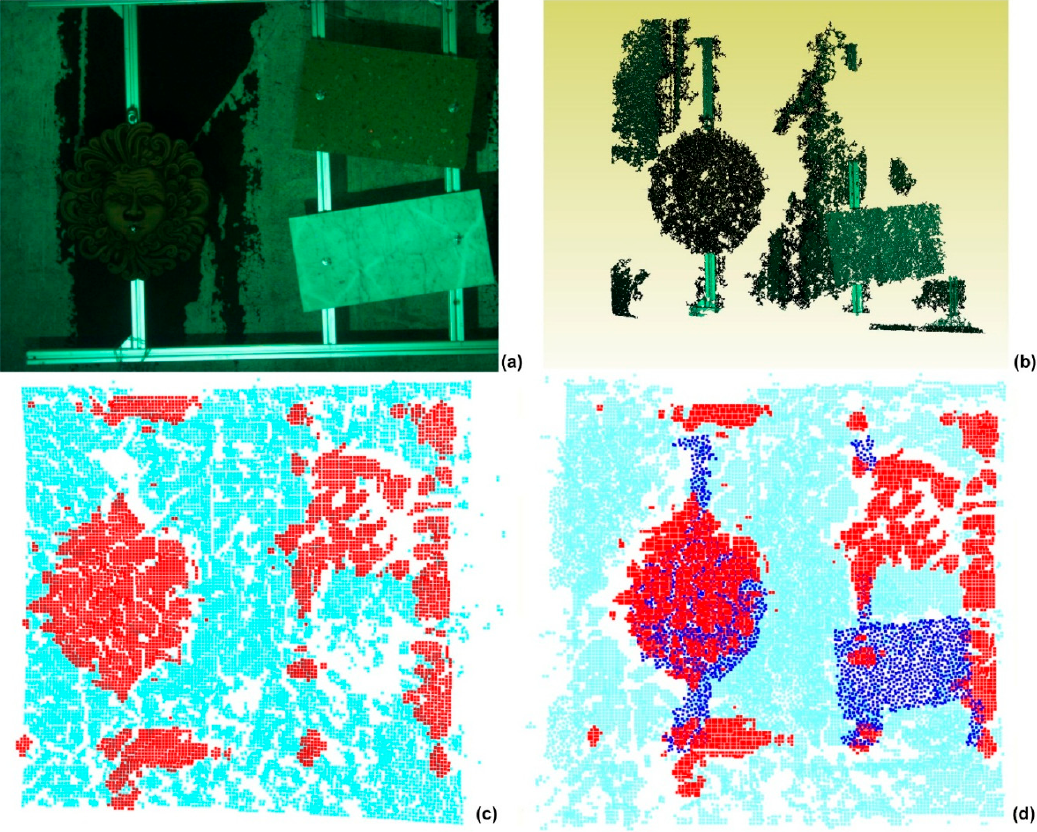
Figure 19. A pose of the target with objects ( a ), optical 3D point cloud; ( b ), acoustic point cloud; ( c ), opto-acoustic reconstruction of the scene ( d ).